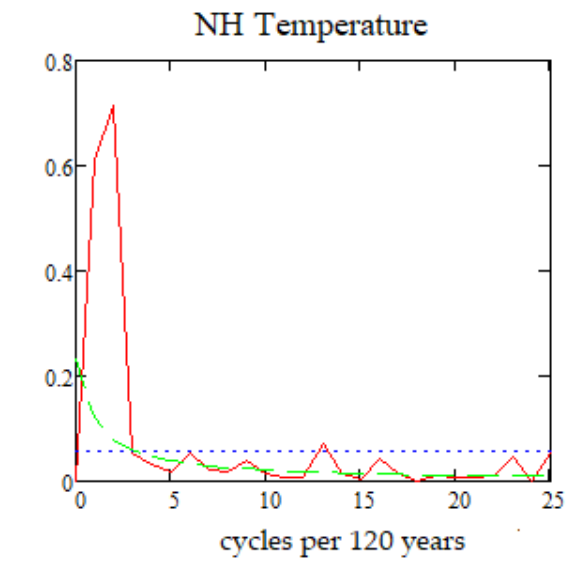
Figure 6. The spectral analysis of the detrended NH time series for the NH (red). The dotted (dashed) line is the 95% confidence level assuming a white (red) noise spectrum (see [58]). The abscissa unit is cycles per 120 years and the ordinate unit is spectral power (°C 2 ).